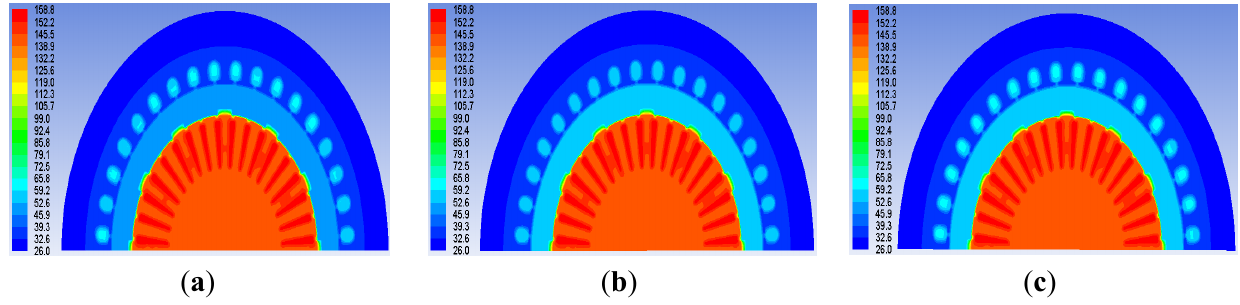
Figure 18. Thermal field distribution of three cross-sections: ( a ) the water inlet side; ( b ) the middle cross-section; and ( c ) the water outlet